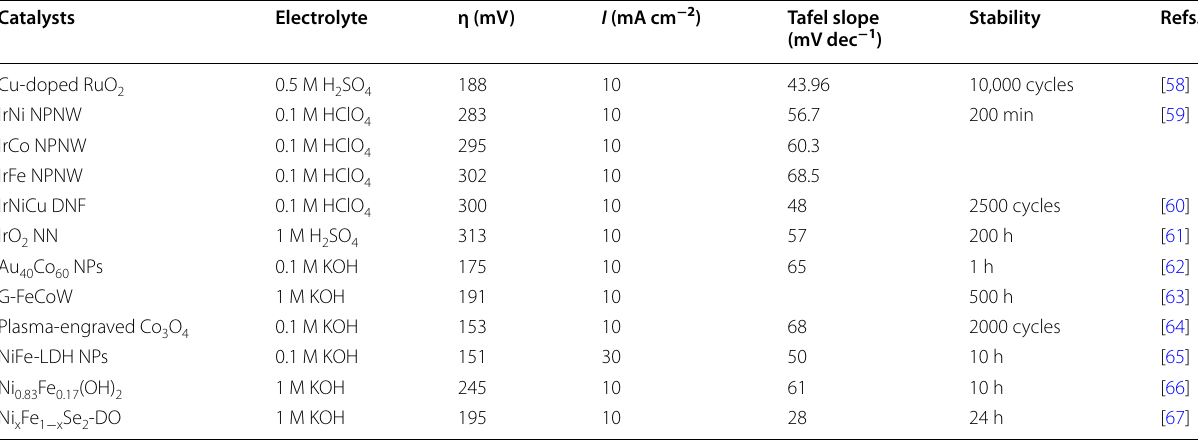
Table 2 Summary of the OER performance of the reported electrocatalysts